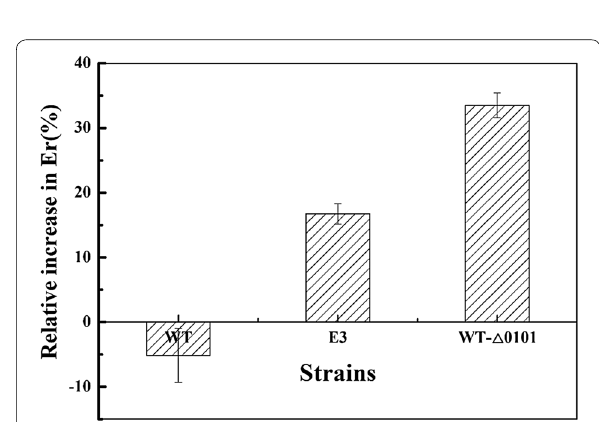
Fig. 5 The relative increase in erythromycin production in strains WT, E3, and WT-Δ0101 after adding Cu 2 + . WT showed no visible change, while E3 and WT-Δ0101, respectively, increased 16.73% and